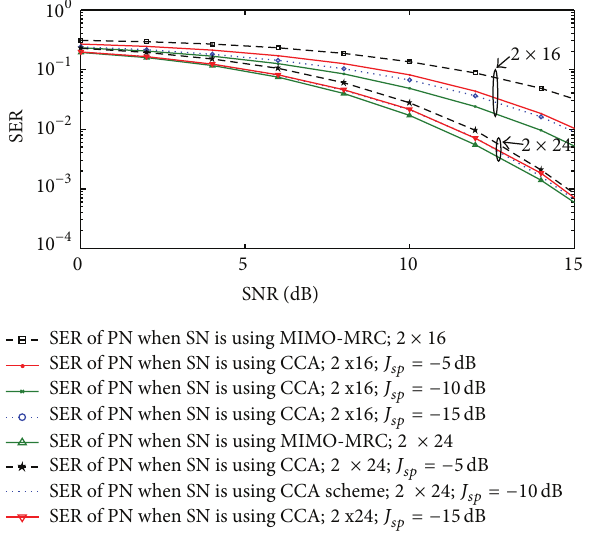
Figure 3: Impact of 𝐽 max 𝑠𝑝 on the SER of PUs when the SN is using CCA and MIMO-MRC